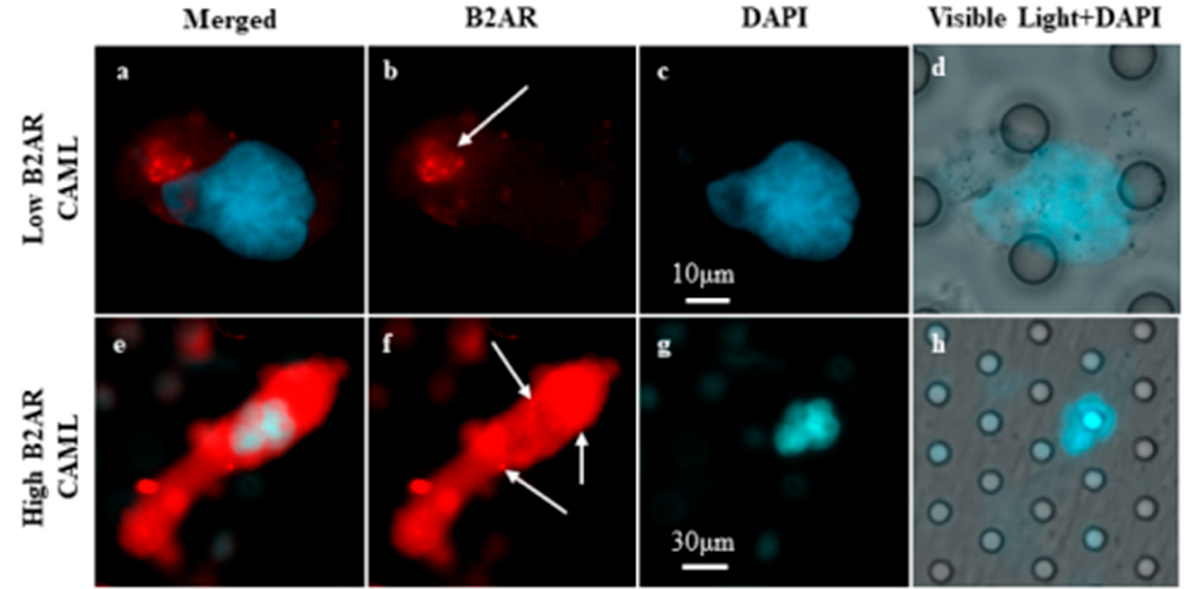
Figure 1. Images of low- and high-B2AR-expressing CAMLs. CAMLs are enlarged cells with a polyploid nucleus (blue) and can be B2AR-positive (red). ( a – d ) CAMLs showing low expression of B2AR (box = 60 μ m, scale bar = 10 μ m), with the white arrow pointing to potential internalization. ( e – h ) CAMLs showing high expression of B2AR (box = 180 μ m, scale bar = 30 μ m), with the white arrow pointing to potential internalization.